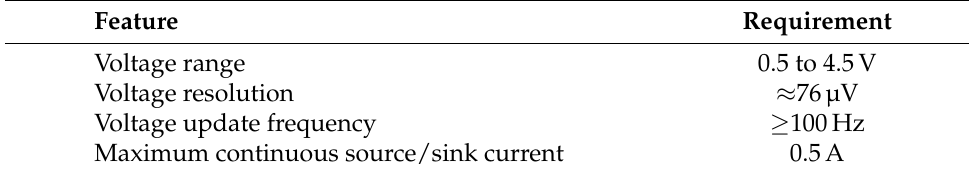
Table 1. Design constraints of the cell